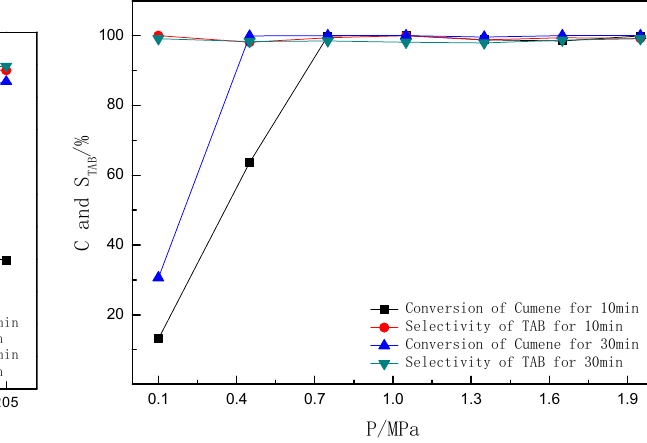
Figure 6: The: e ff ect of reaction pressure on conversion of cumene and selectivity of TAB.